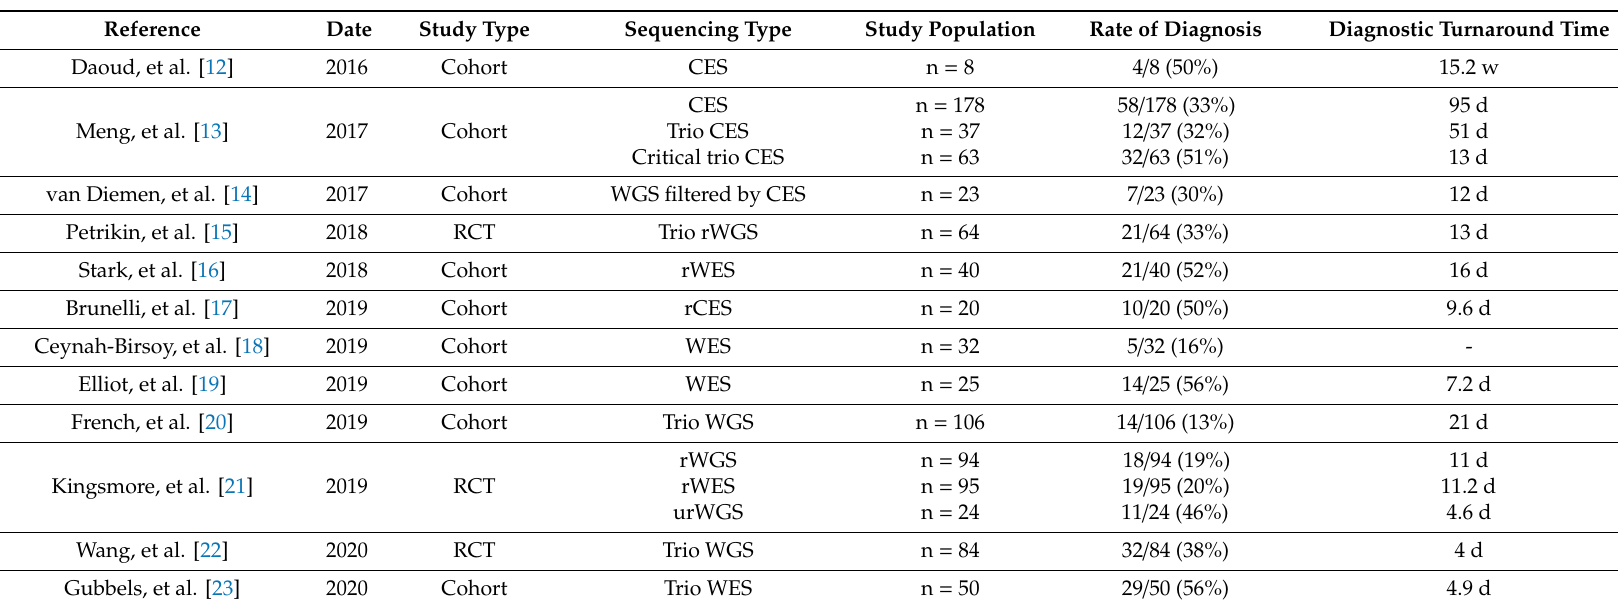
Table 4. Previous prospective studies of the diagnostic performance of WES, WGS, and CES in newborns with a suspected genetic